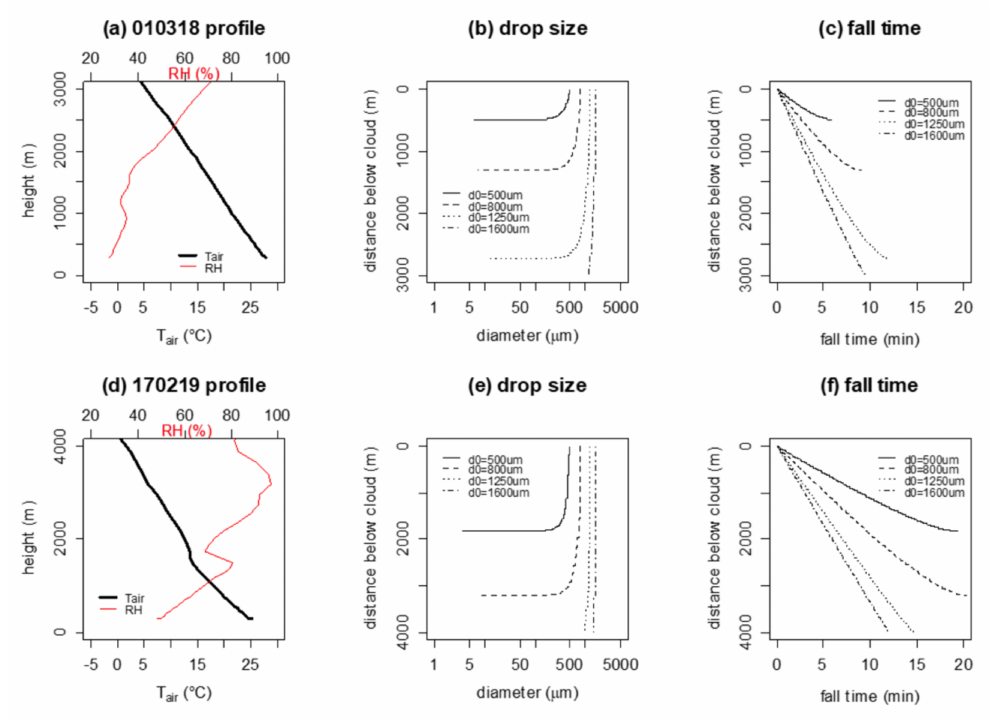
Figure 4. Calculated fall speed properties of droplets using Equation (1), assuming thermodynamic profiles from the ECMWF reanalysis for periods at Al Ain when rain was observed, ( a ) 1200 UTC 1 March 2018 and ( d ) 1000 UTC 17 February 2019. ( b ) and ( e ) show calculated droplet size variations with distance beneath cloud base for droplets leaving the cloud with a range of initial diameters falling at terminal velocity in the conditions of ( a ) and ( d ); ( c ) and ( f ) show the associated fall times for the same initial droplet sizes (the locally observed cloud base heights were 3 km and 4 km,